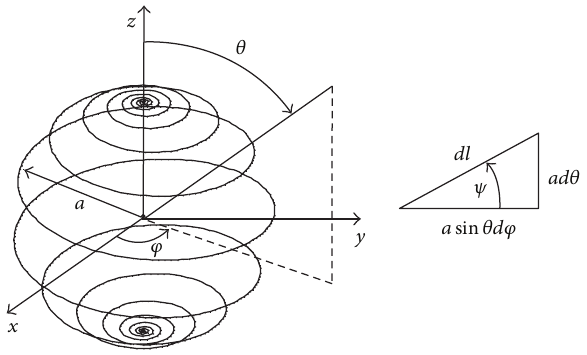
Figure 2: Basic SHA